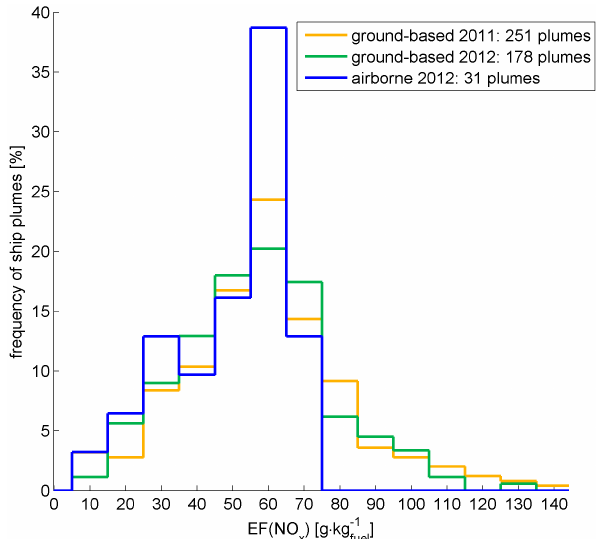
Figure 7. Averaged normalized size distribution of the EF(PN) and the cumulative sum of the median EF(PM) distribution over parti- cle size. Around 77% of the particles in the range 5.6nm to 10µm were found to be between 7 and 65nm in size. Around 70% of the EF(PM) is from particles below